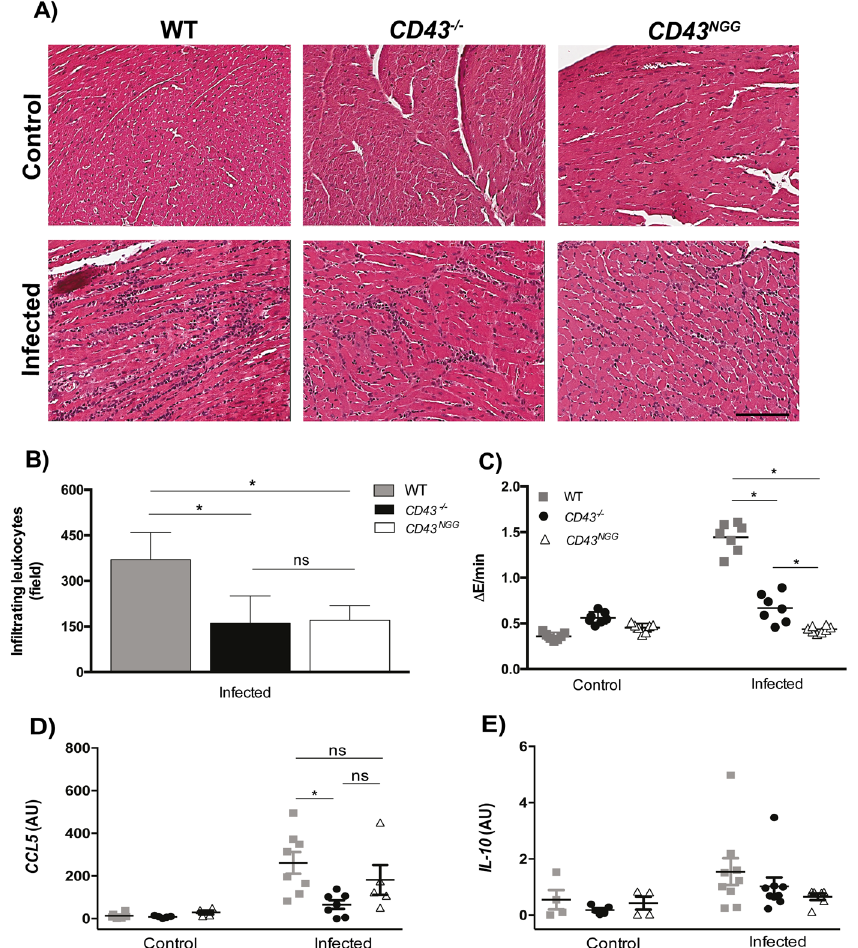
Figure 6. Reduced inflammatory infiltration and cardiac tissue damage in CD43 mutant mice. ( A ) Representative histology analysis of the heart tissue of control and infected mice (n = 5 mice per group). Calibration bar: 100 μ m. ( B ) Quantification of heart infiltrating leukocytes in a total of 10 fields from each heart tissue sample (n = 5 mice per group - * p = 0.021). ( C ) Biochemical analysis of NAPDH levels related to the activity of the cardiac isotype of Creatine Kinase – MB. Plasma from non-infected animals was used as control for base line CK activity ( * p < 0.0001). ( D , E ) qRT-PCR analysis for the relative expression of CCL5 ( * p = 0.023) and IL-10 genes